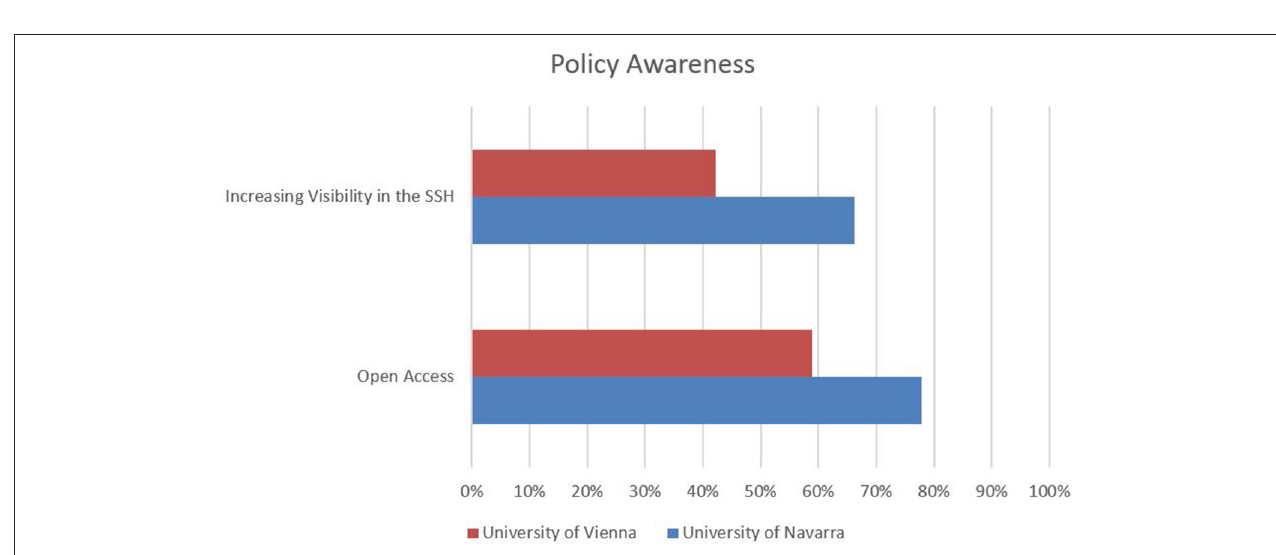
FIGURE 10 | Policy